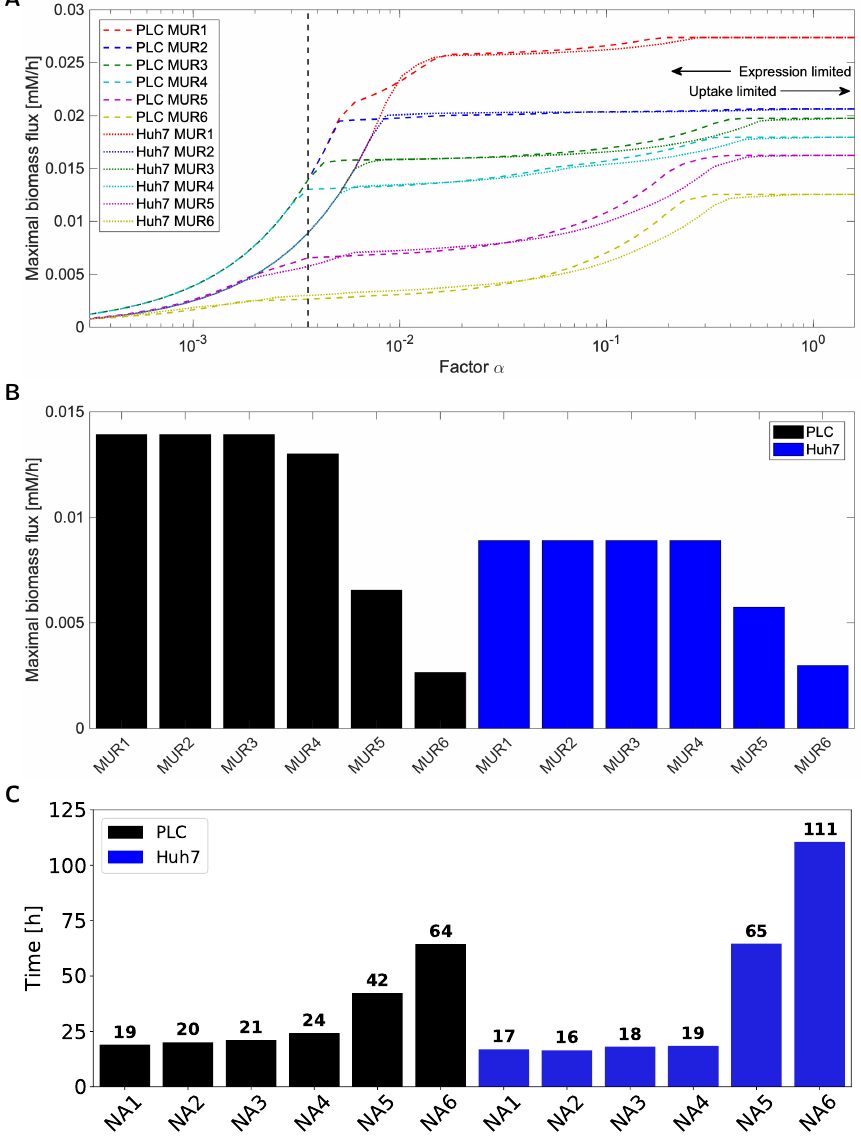
Figure 3. ( A ) Maximal in silico biomass flux predictions for Huh7 (dashed lines) and PLC (dotted lines) on six MURs versus the factor used to convert RAS to flux bounds. The labels MUR1-6 corresponds to the different medium conditions listed in Table 1 in Material and Methods and Table S4 and were effected as proportional uptake (exchange) bounds: Glucose and glutamine were (in mM) 25, 4 (MUR1), 25, 0 (MUR2), 5.6, 4 (MUR3), 5.6, 0 (MUR4), 0,4 (MUR5) and 0,0 (MUR6). The dashed black line indicates α = 0.0036, the value of the factor α that we shall consider more in detail below and at which the maximal biomass flux predictions for MUR1-4 become virtually equal for both cell lines. ( B ) Maximal in silico biomass flux predictions for PLC and Huh7 across the six GEM-RAS-MUR models. ( C ) Reciprocal of the cells doubling time calculated from a linear equation describing the change in cell number over the time for PLC and Huh7 across the six different media